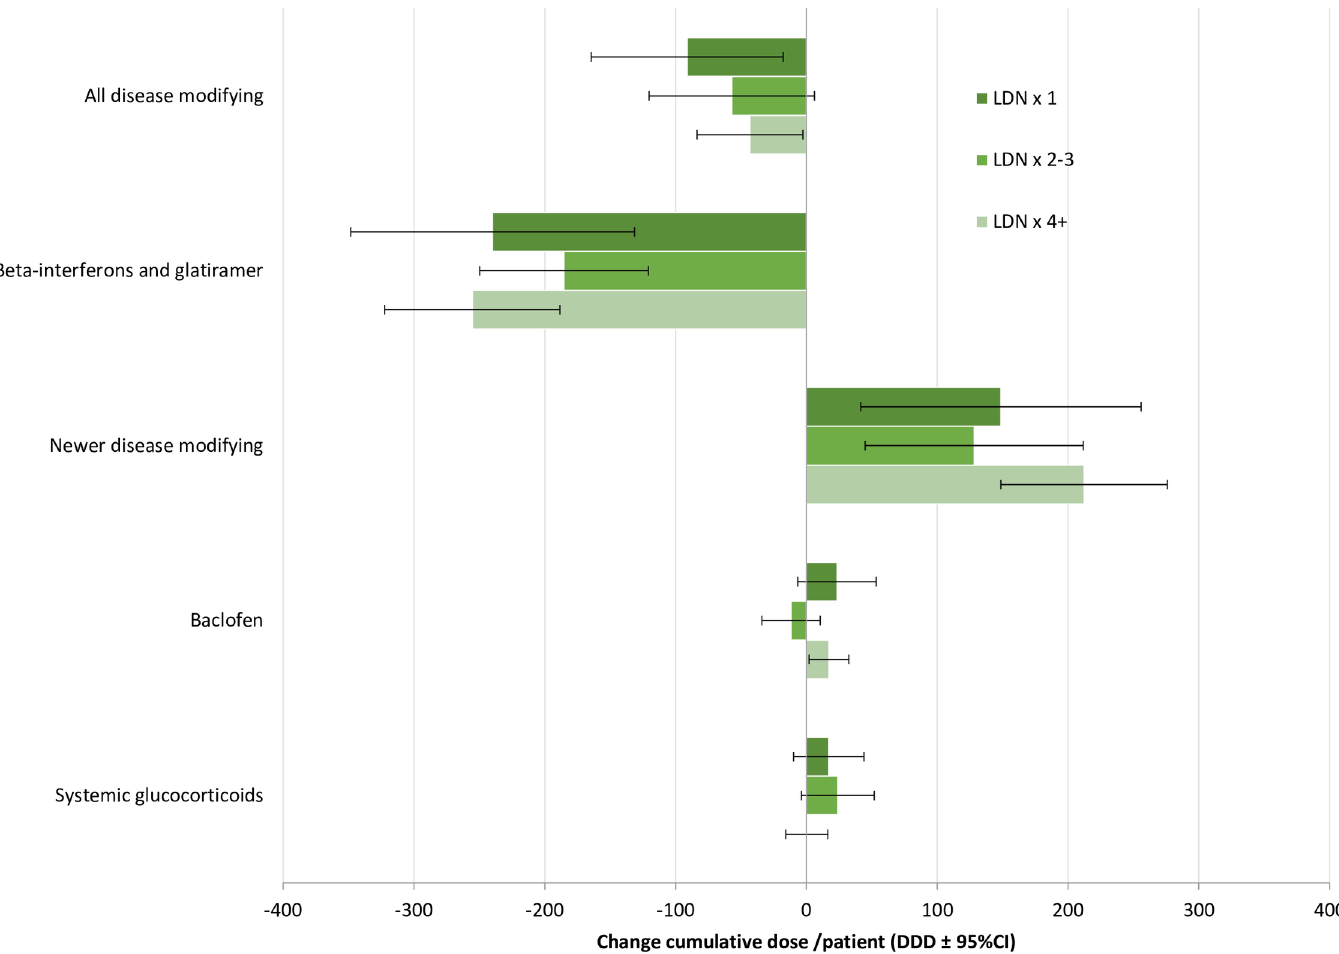
Fig 2. Differencein dispensing of disease modifying MS agents, baclofen and systemic glucocorticoid after initiation of LDN therapy by number of LDN dispenses. Newer diseasemodifyingMS agents includefampridin,fingolimod,teriflunomide and dimethyl fumarate. Cumulative dose in DDD per patient two years prior to Index date comparedto two years